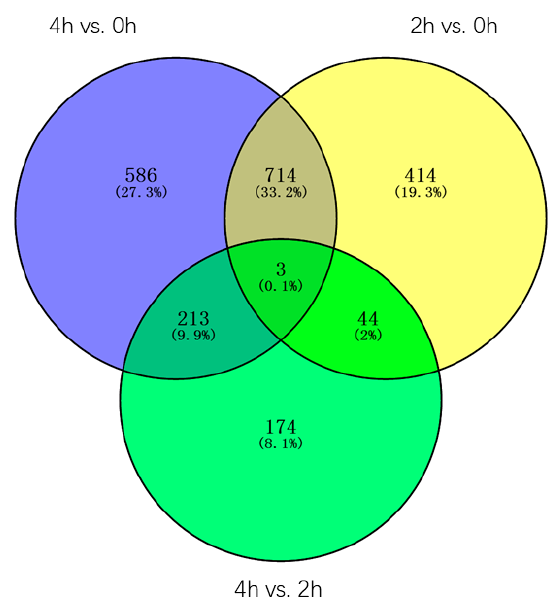
Figure 7. Venn diagram of 2148 DEGs expression profile changes.